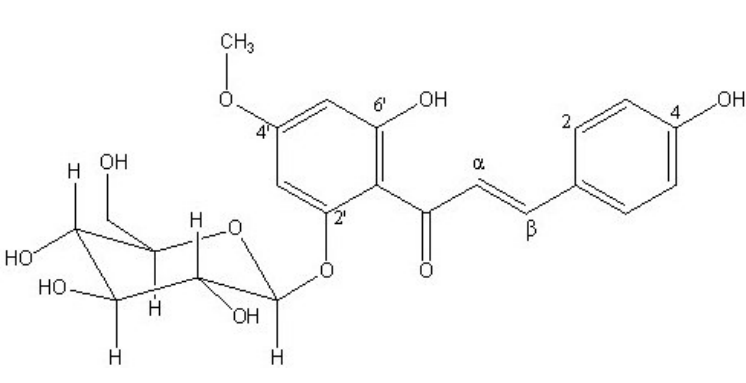
Figure 1. Structure of compound 1